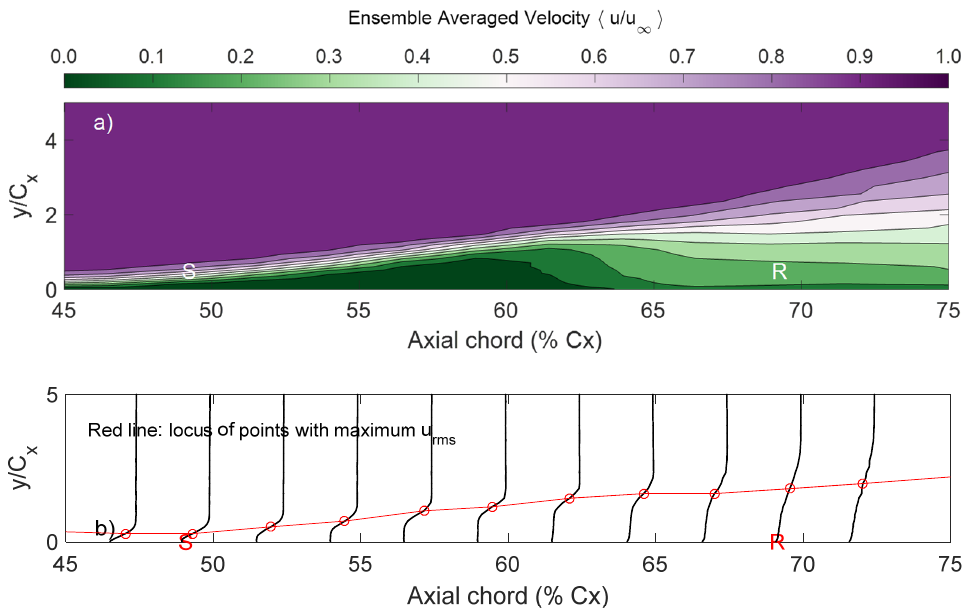
Figure 3. Averaged streamwise velocity, (cid:104) u / u ∞ (cid:105) , measured using the CTA around the separation bubble: ( a ) contour map, ( b ) wall normal velocity profile. S and R show approximate locations of separation and reattachment, respectively. The red line is the locus of maximum u rms intensity.